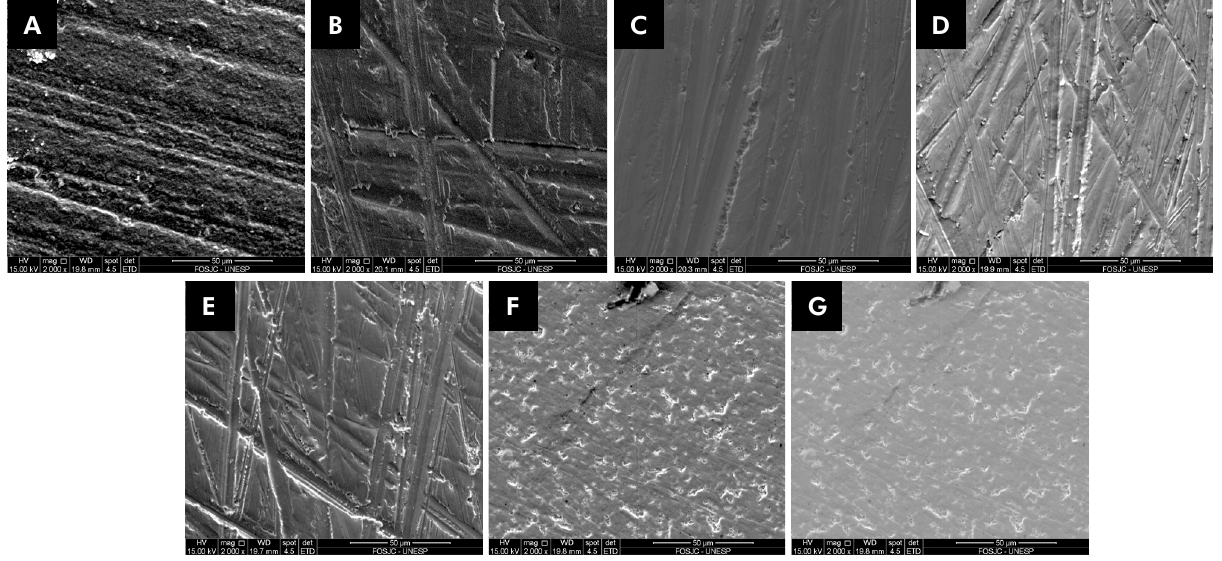
Figure 1. Scanning electron microscopy (2,000x magnification) of surface patterns in each group. Control (Top, center); G80 (1 st row, left column); G80A (1 st row, right column); G120 (2 nd row, left column); G120A (2 nd row, right column); G600 (3 rd row, left column); G600A (3 rd row, right